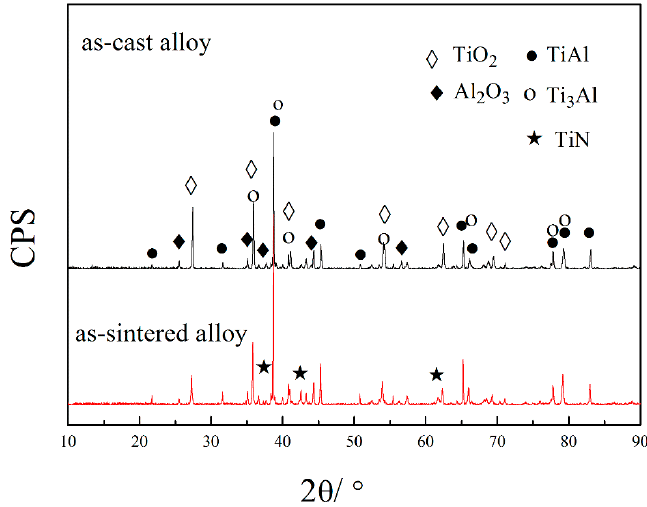
Figure 11. The X-ray diffraction patterns of both as-casted and sintered TiAl alloys after oxidation at 900 °C for 100 h. Metals 2018 , 8 , x FOR PEER REVIEW